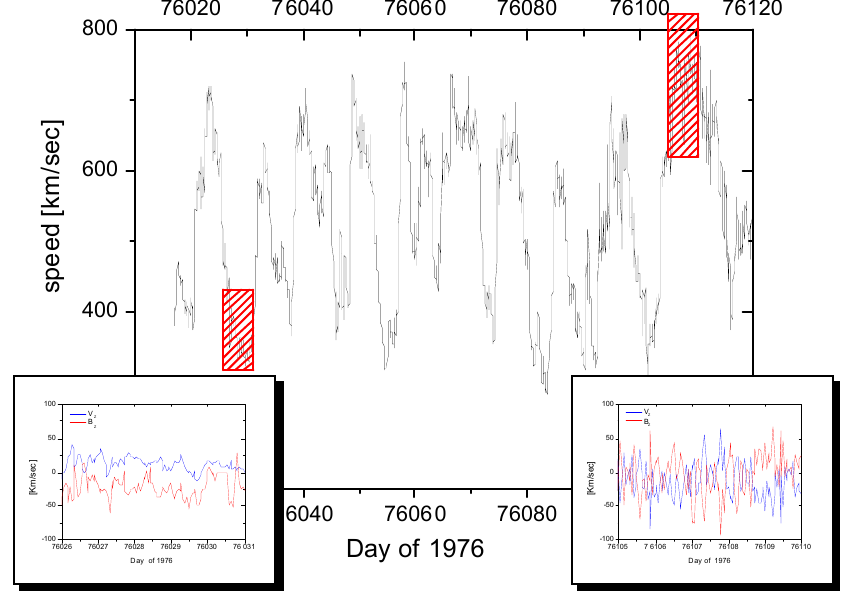
Figure 37: Alfv´enic correlation in fast and slow wind. Notice the different degree of correlation between these two types of